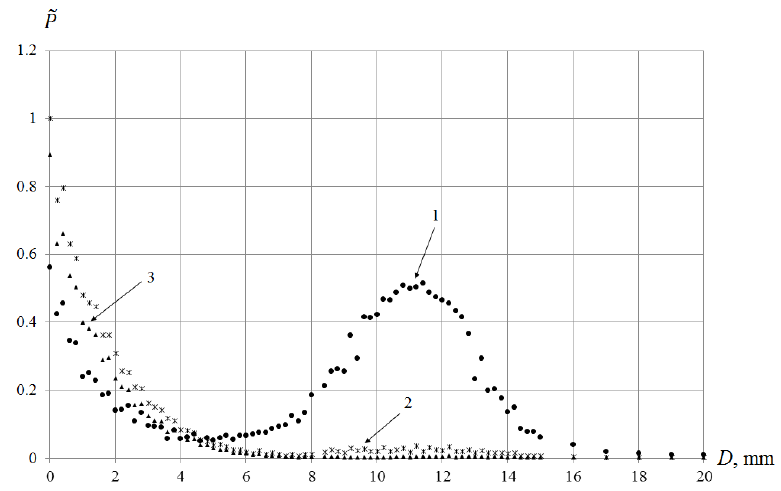
Fig. 2. The dependence of the normalized power flux density on a distance to the dielectric waveguide.